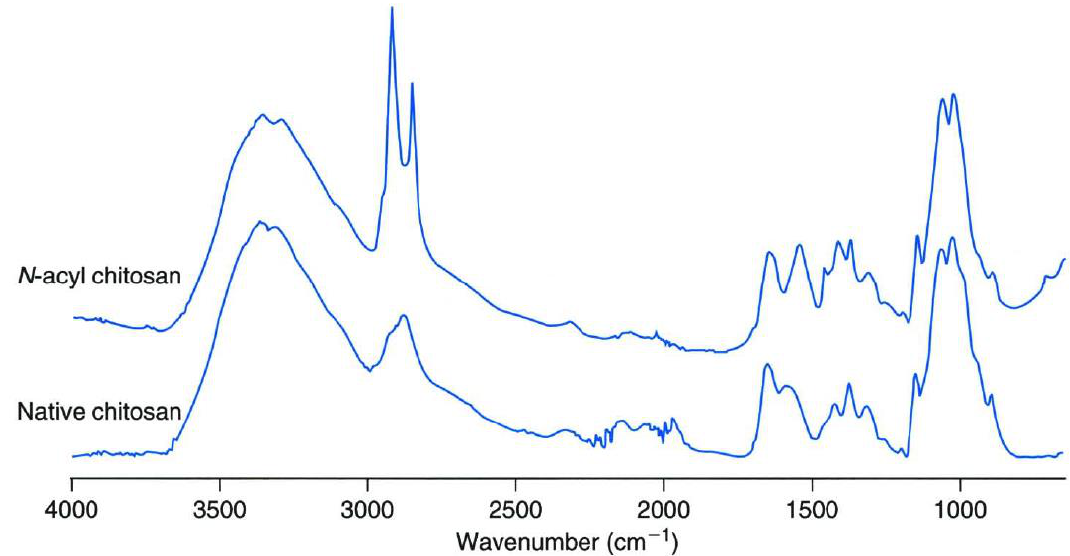
Figure 20. Fourier-Transform Infrared Spectroscopy (FTIR) spectrogram of the polysaccharide films. Reproduced with permission from [6] ( Copyright 2005 Elsevier ).